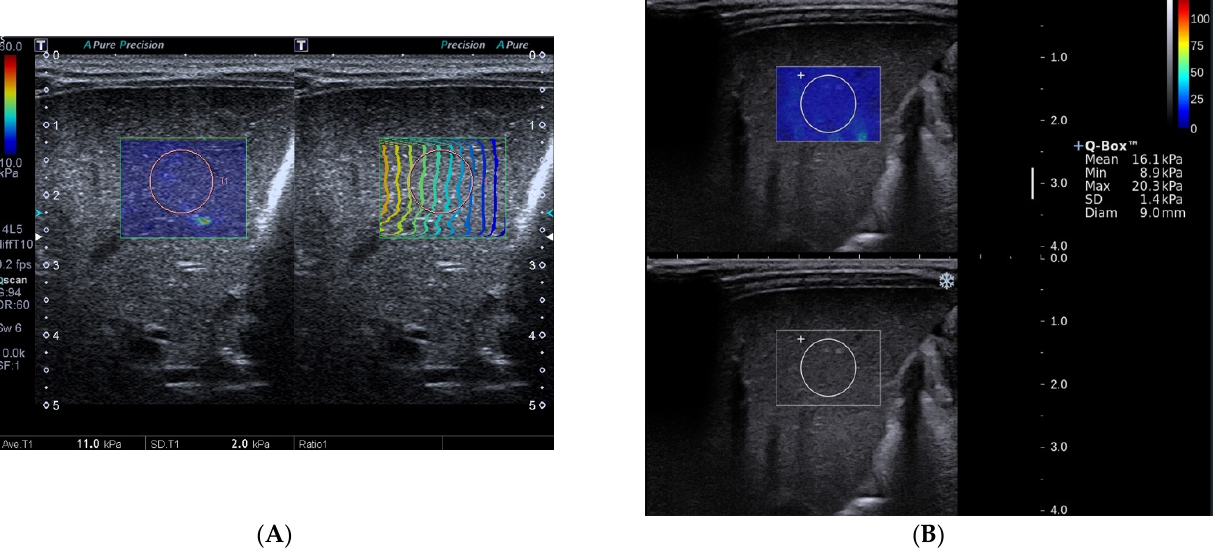
Figure 1. Toshiba shear wave elastography measurements ( A ) and Supersonic shear wave elas-